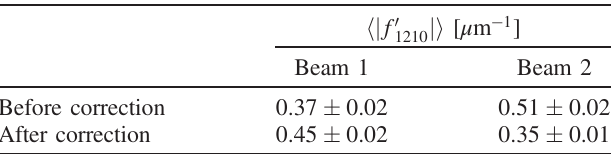
TABLE VI. Strength of the f 0 1210 skew-octupole RDT before and after application of correction for skew octupole feed-down. Values are the average absolute resonance strength measured around the